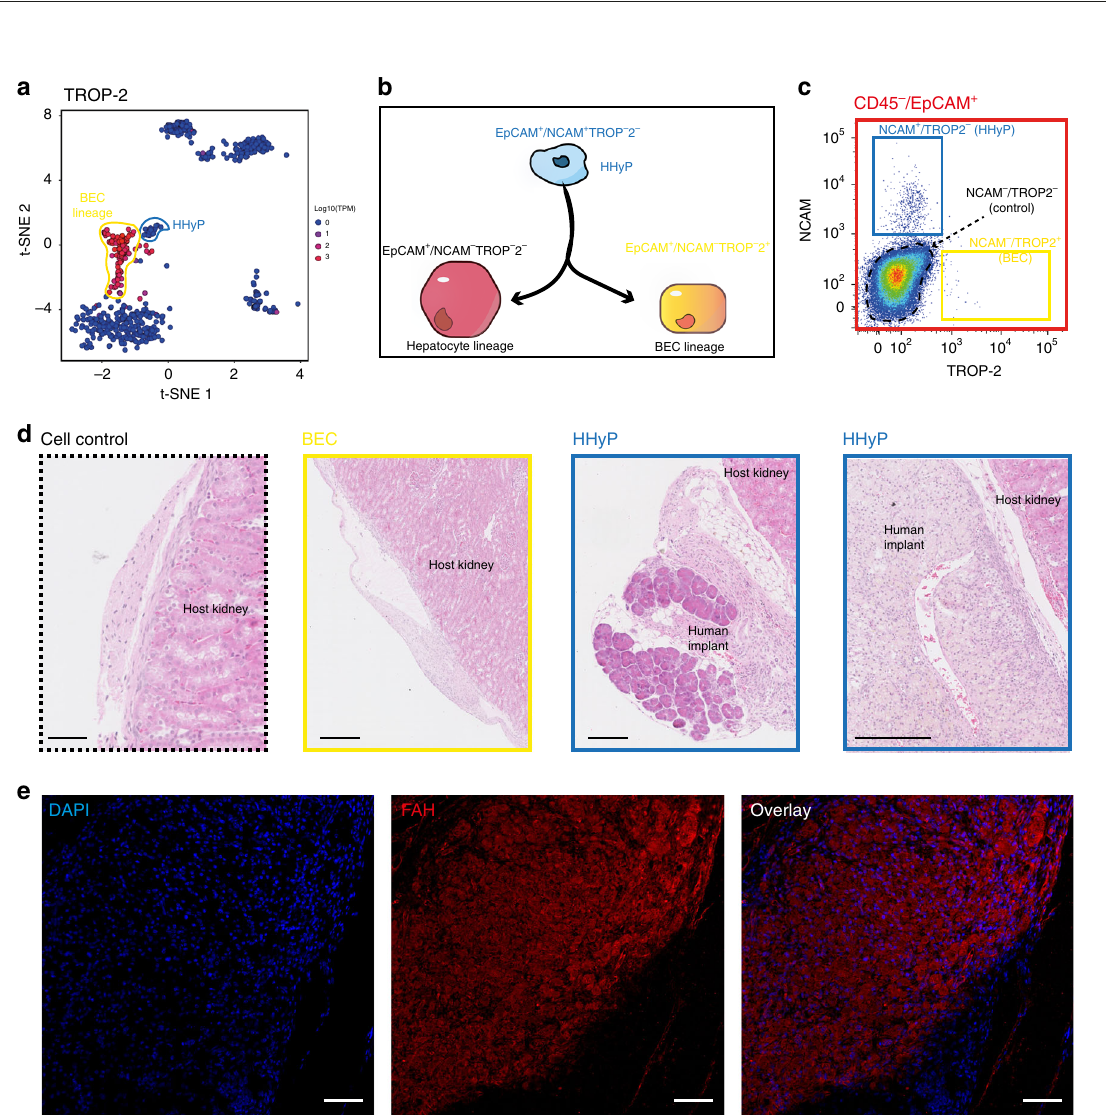
Fig. 5 In vivo lineage potential of human foetal HHyPs. a Experimental strategy for isolation and in vivo characterisation of foetal hepatobiliary hybrid progenitors (HHyPs) by transplantation beneath the renal capsules of immunode fi cient NOD scid gamma (NSG) mice. b 2D t-SNE visualisation of single cells isolated from foetal human liver coloured by FACS gating population (left panel) and transcript expression of ALB and MCAM overlaid on the 2D t- SNE space of human foetal liver scRNA-seq analysis (right panel). Expression is Log10(TPM). c Gating scheme for the isolation of distinct foetal human liver populations based on expression of CD235a, CD45, EpCAM, NCAM and MCAM. d Hematoxylin and eosin (H&E) staining in tissue cross-sections of implant regions 4 weeks post renal capsule transplantation of human foetal liver FACS populations. Scale bars represent 100 μ m. e Immuno fl uorescence (IF) co-staining of CK19 (green) and ALB (red) in implant regions of HHyPs post 4 weeks transplantation and matched control mouse adult liver. Slides counterstained in DAPI (cyan). Scale bar represents 25 μ m. f IF staining of FAH (red) and HNF4A (green) in implant region of HHyPs 4 weeks post transplantation. Slides counterstained in DAPI (cyan). Scale bars represent 25 μ m. g IF co-staining of TROP-2 (white) and ALB (red) in implant region of HHyPs 4 weeks post transplantation. Slides counterstained in DAPI (cyan). Scale bars represent 25 μ m. t-SNE t-distributed stochastic neighbour embedding, FACS fl uorescence-activated cell sorting, TPM transcripts per million